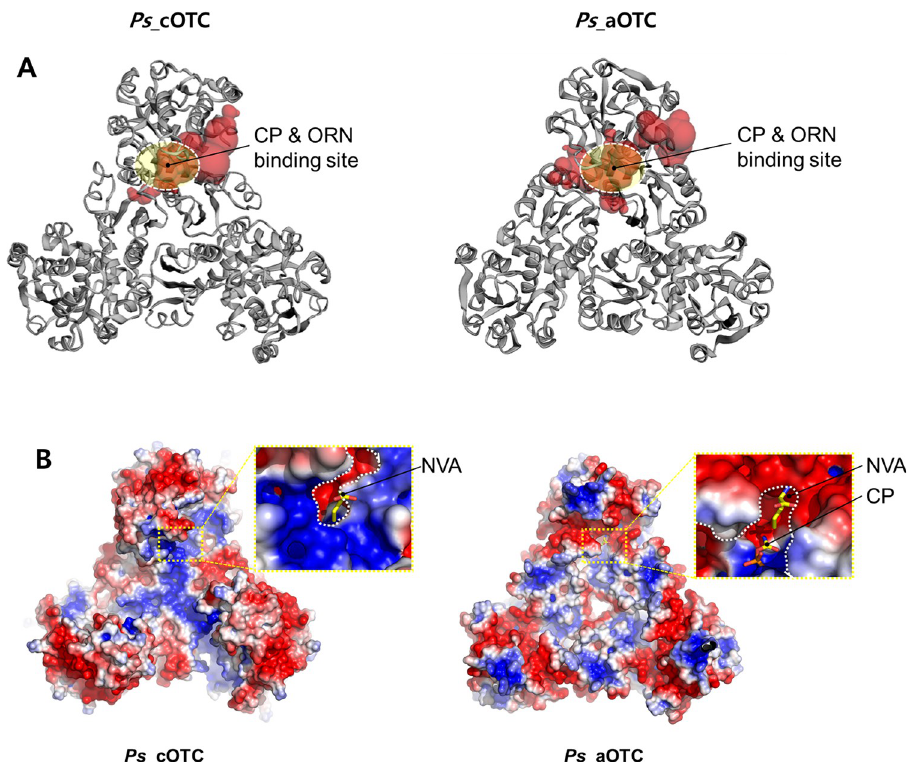
Fig 6. Comparison of the substrate binding site. (A) Measurement of concave surface regions on Ps _cOTC and Ps _aOTC using the Computed Atlas of Surface Topography of proteins (CASTp). The pocket regions of each protein are visualized with red blobs. The active site is indicated with a white dotted circle. (B) The surface electrostatic potential of OTCs is shown as red ( − 3 kT/e) and blue (+3 kT/e) surfaces. Closed-up views of each binding pocket with CP and NVA bound to Vvu OTC from Vibrio vulnificus (PDB code: 4H31) are indicated by yellow